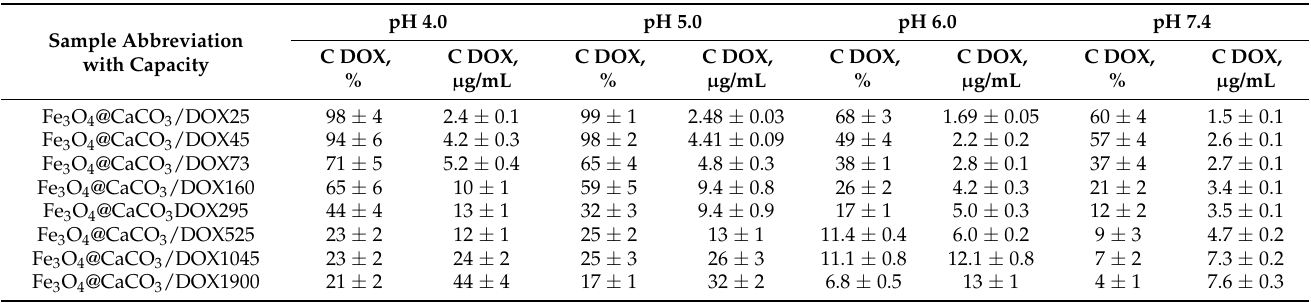
Table 3. DOX release efficiency from Fe 3 O 4 @CaCO 3 /DOX at pH 4.0–7.4 at 25 ◦ C for 24 h. Sample Abbreviation with